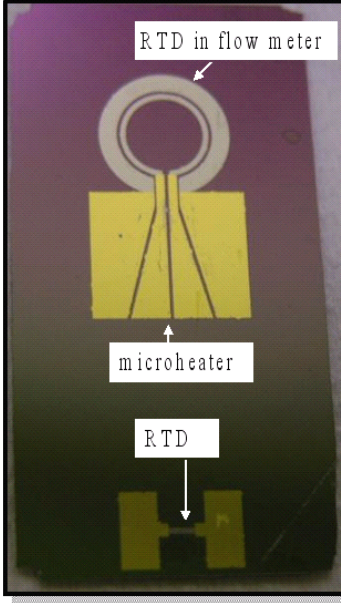
Figure 6. Photograph of circular thermal flow meter and RTD used for temperature compensation purposes (upper: flow meter, lower: